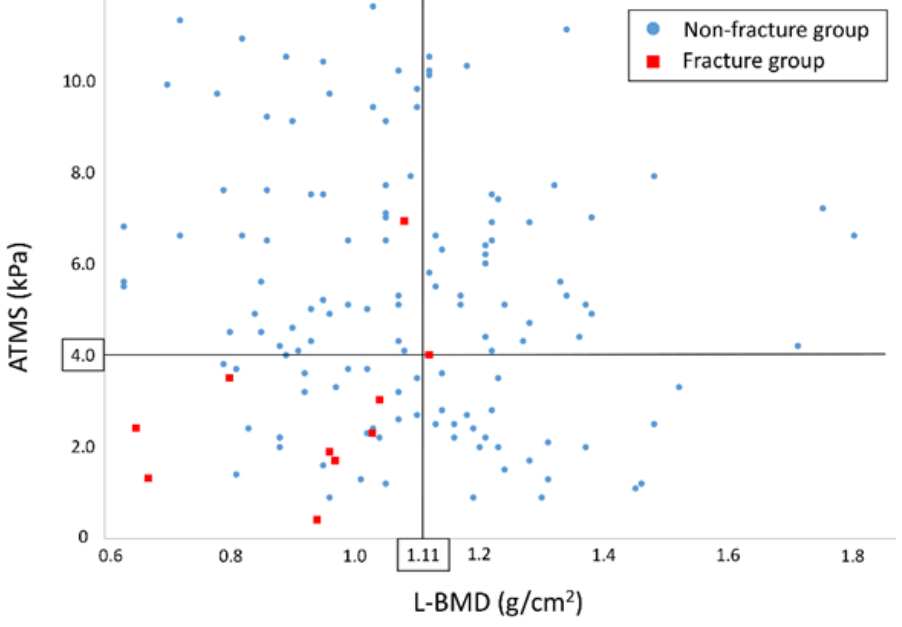
Figure 3. The distribution according to the patients’ AMTS and L-BMD at the first preoperative evaluation. The occurrence rate of new OVF was significantly higher in participants with AMTS values ≤ 4.0 kPa (16.1%, 9/56) than in those with AMTS values > 4.0 kPa (1.2%, 1/85, p = 0.001). It was also significantly higher in participants with L-BMD values ≤ 1.11 g/cm 2 (11.0%, 9/82) than in those with L-BMD values > 1.11 g/cm 2 (1.7%, 1/59, p = 0.031). Abbreviations: AMTS, abdom- inal trunk muscle strength; L-BMD, bone mineral density of the lumbar spine; OVF, osteoporotic vertebral